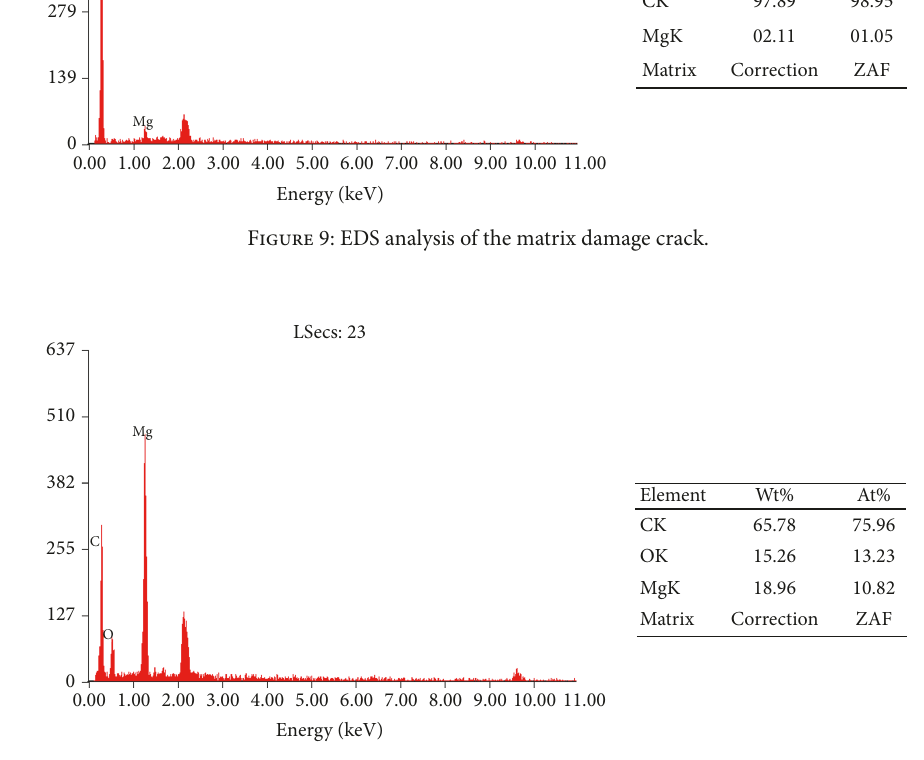
Figure 10: EDS analysis of the matrix damage